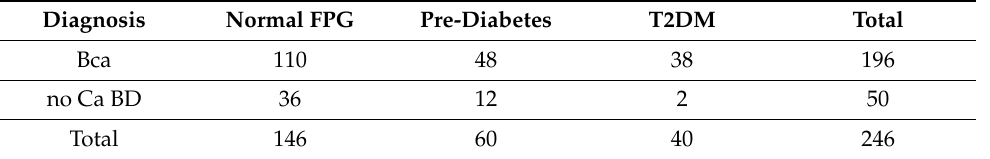
Table 2. Frequencies of patients with pre-diabetes, T2DM and normal glycemia. Diagnosis Normal FPG Pre-Diabetes T2DM Total Bca 110 48 38 196 no Ca BD 36 12 2 50 Total 146 60 40 246